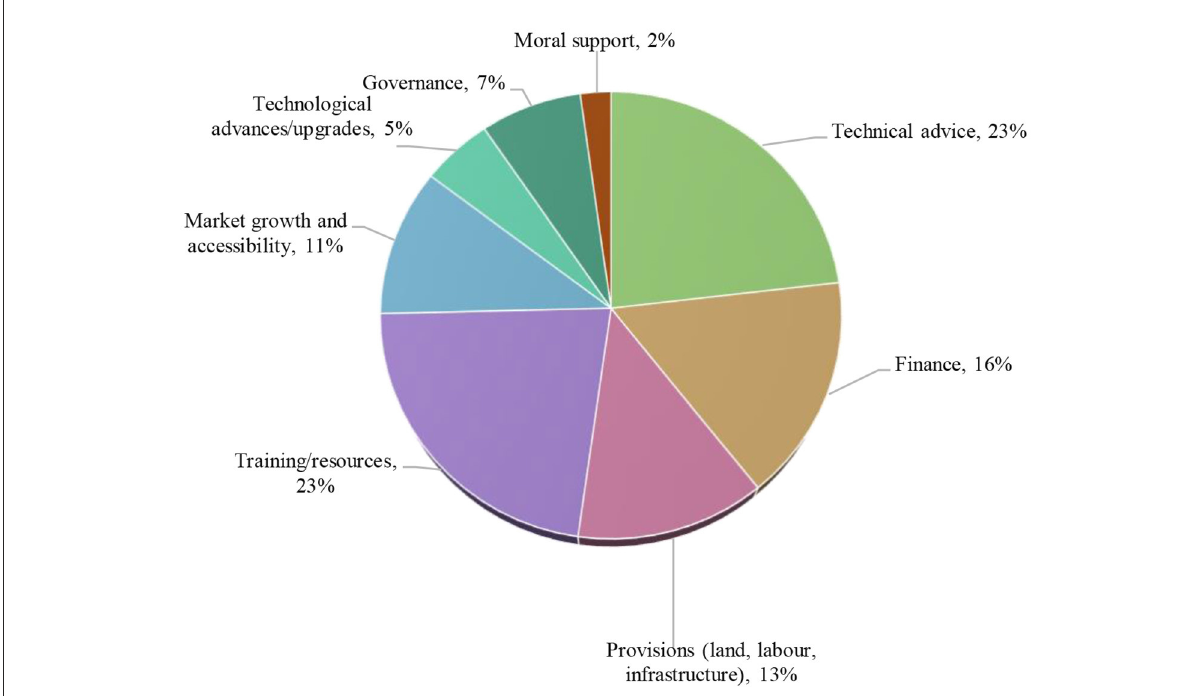
FIGURE6 Egg producers’ perception of the support needed to transition to cage-free systems, by emerging